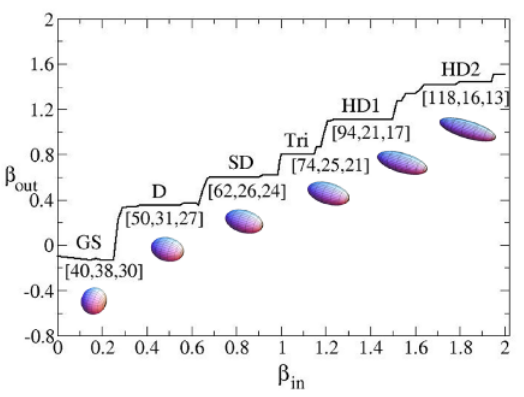
Fig. 3. Quadrupole deformation of the 56 Ni nucleus from the Nilsson-model with the e ff ective U (3) quantum numbers and schematic illustrations of the shape at the